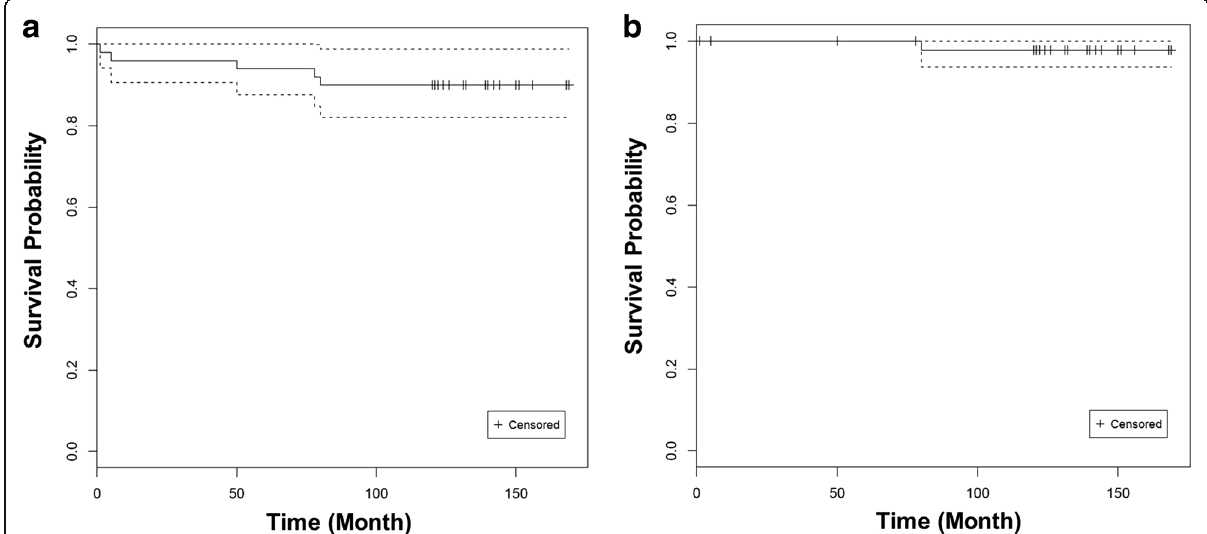
Fig. 2 Kaplan-Meier survival analysis of revision THAs using HXLPE liner. ( a ) Survival with re-revision for any reason as the end point; ( b ) Survival with re-revision for aseptic loosening as the end point. Dotted lines indicating 95% confidence